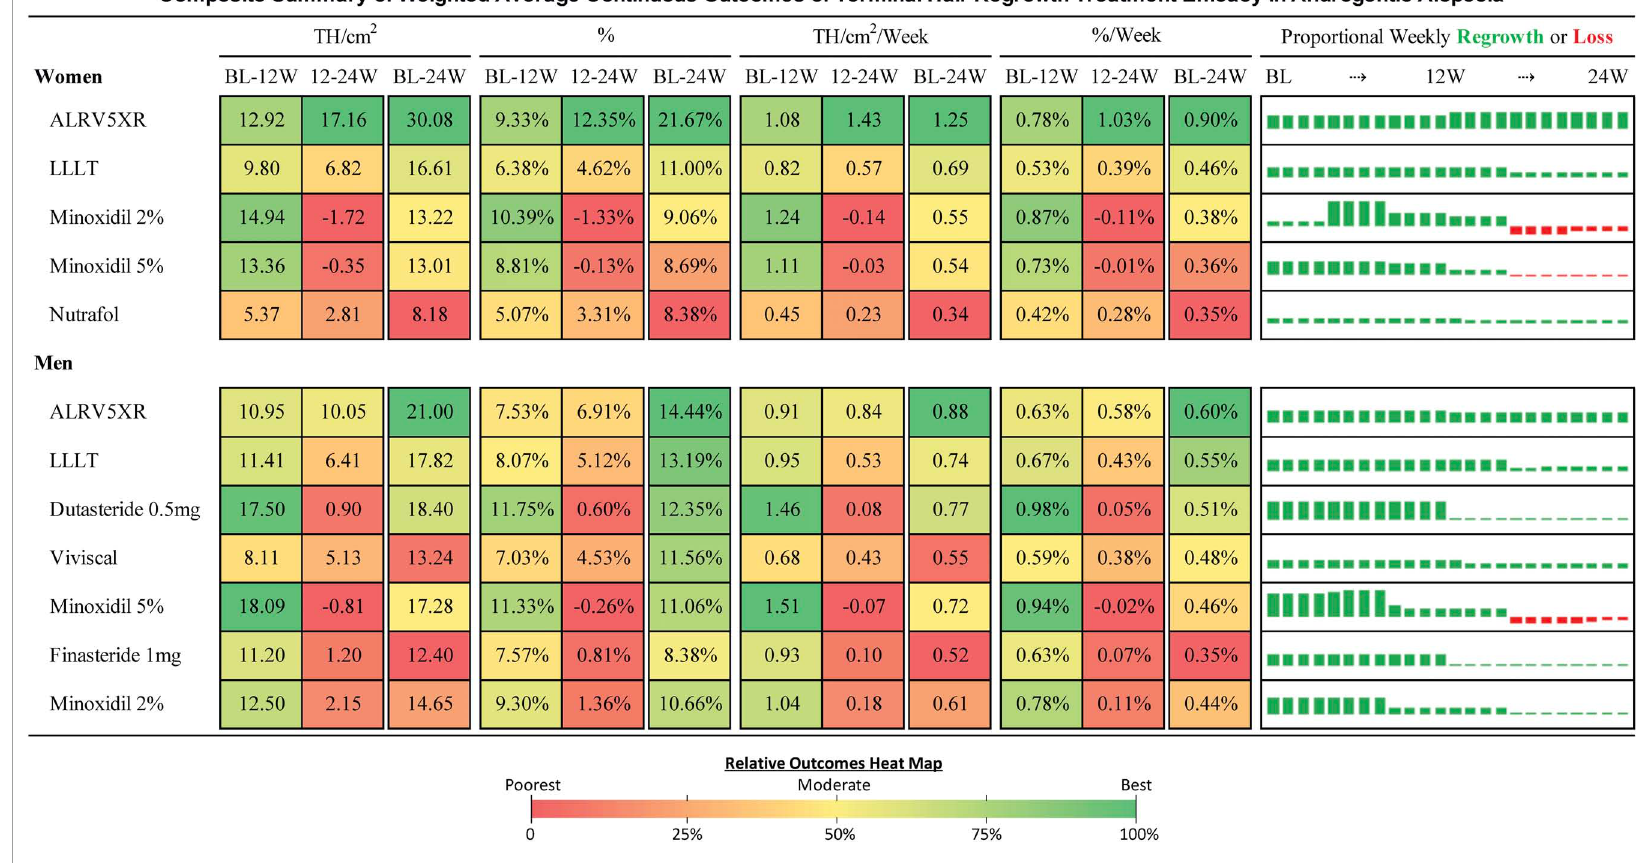
FIGURE7 Composite summary of terminal hair regrowth from weighted average continuous outcomes analysis. This composite outcomes table provides a comprehensive overview of the treatments from weekly imputed data points for all eligible studies. Efficacy of each treatment is the difference between treatment and Placebo weighted by the N of each respective cohort. Efficacy percent is the change divided by the baseline of each cohort and weighted by the N of each cohort population. The bar charts show weekly regrowth or loss for each of the 24 weeks in TH/cm 2 . Treatments are sorted by the 24 week efficacy determined in the Bayesian NMA. Results may be different from the NMA due to analytical methods. Continuous outcomes have no measures for statistical significance. Heat map colors are green (highest result), yellow (moderate), and red (lowest). Heat maps are shared between BL-12W and 12-24W. The BL-24W column has its own heat map for the overall result. Heat maps are separate for women and